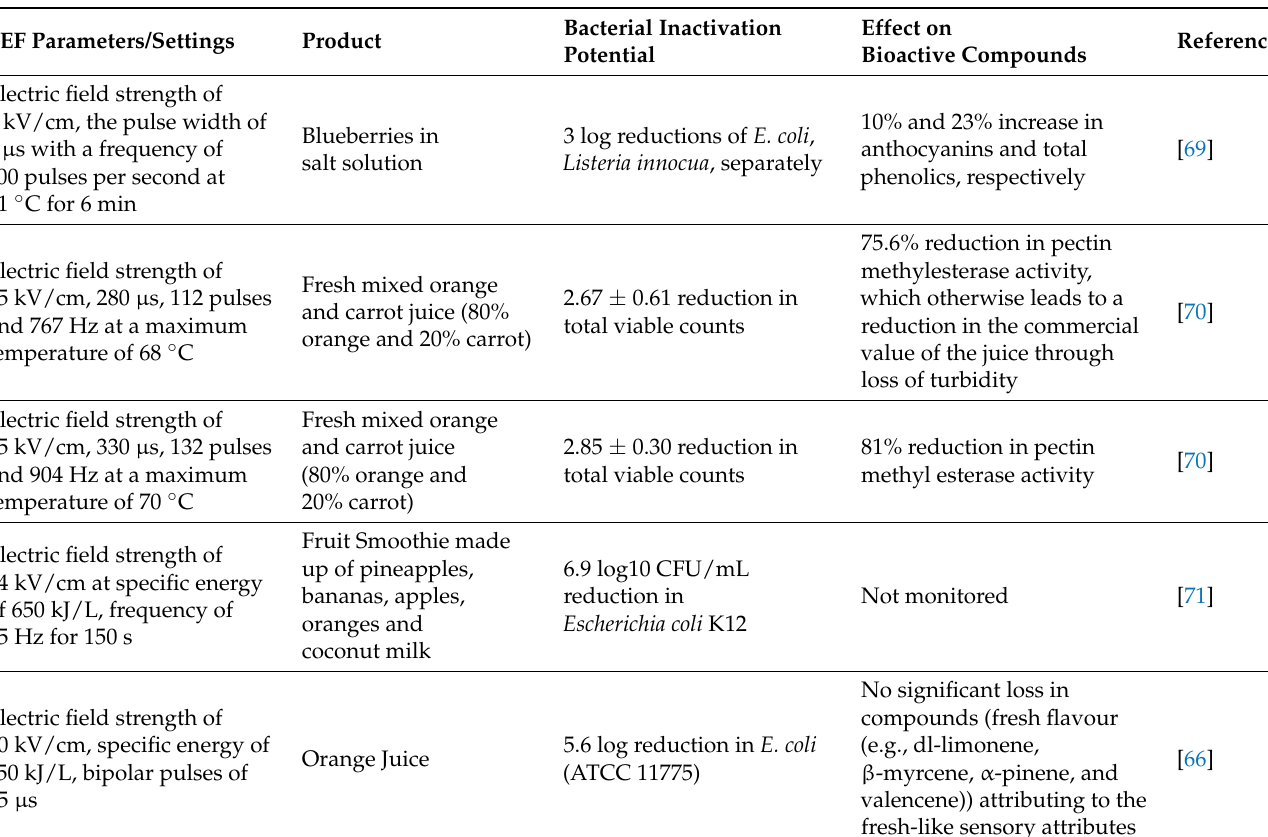
Table 4. Effect of PEF + moderate heat on bacterial inactivation in fruit/vegetable